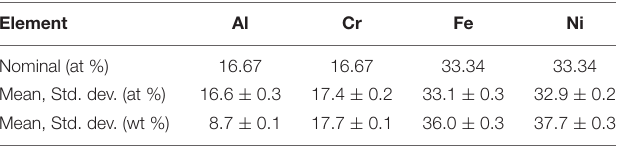
TABLE 1 | Chemical composition of the alloy AlCrFe 2 Ni 2 measured by EDS in an SEM.